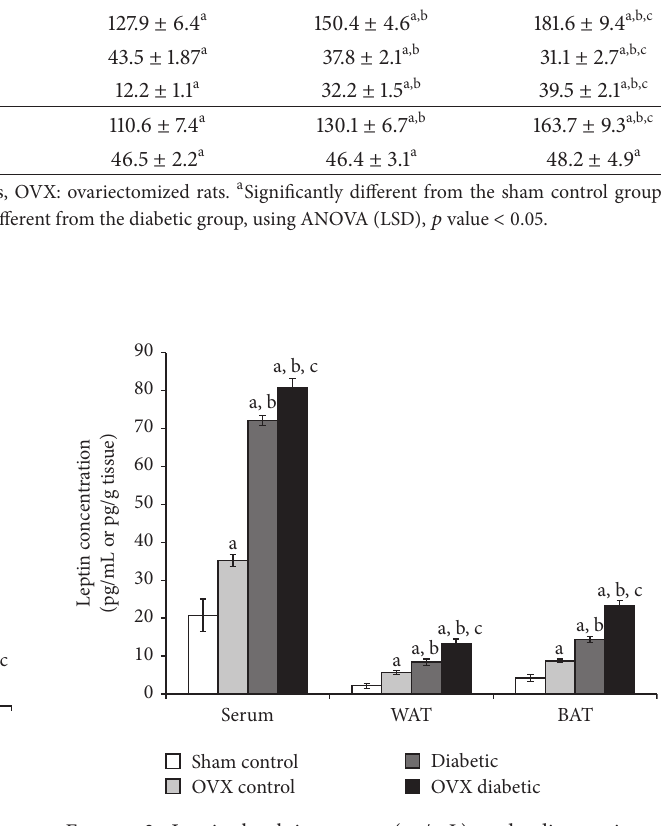
Figure 2: Adiponectin level in serum (ng/mL) and adipose tissues (ng/g tissue) of different studied groups at the end of the study.